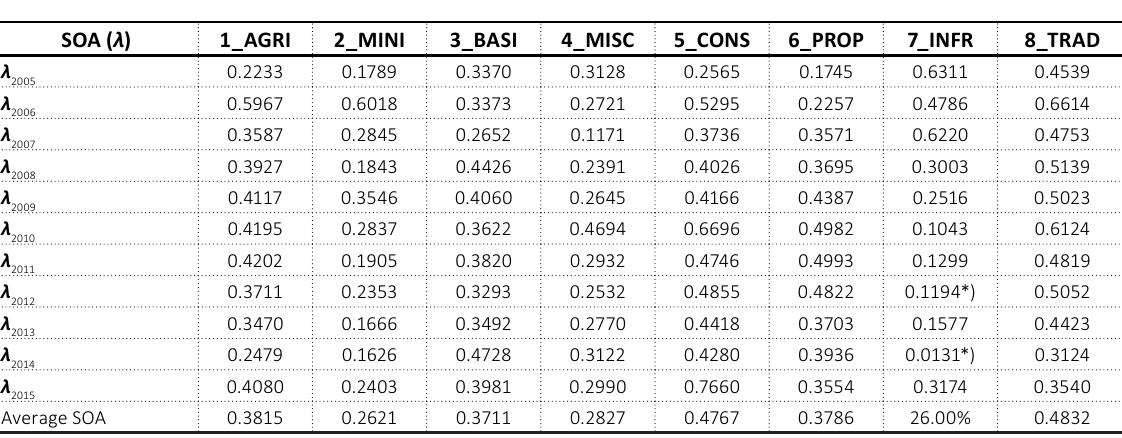
Table 6. Speed of adjustment (λ) across sectors